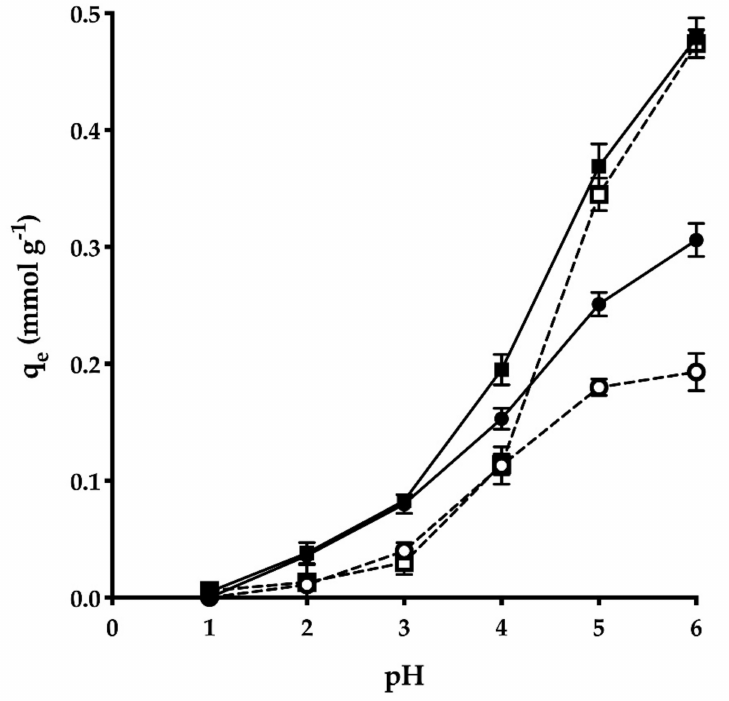
Figure 1. The effects of solution pH on Ni 2+ and Zn 2+ biosorption from aqueous solutions by Lemna gibba in single ( — Ni 2+ , — — Zn 2+ ) and binary (--- --- Ni 2+ , --- --- Zn 2+ ) metal systems.